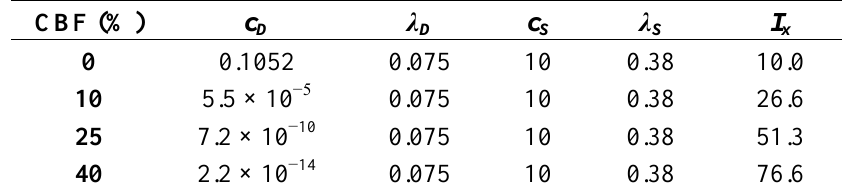
Table 2. Parameter values for simulated D and S time courses. The Hill coefficient n =